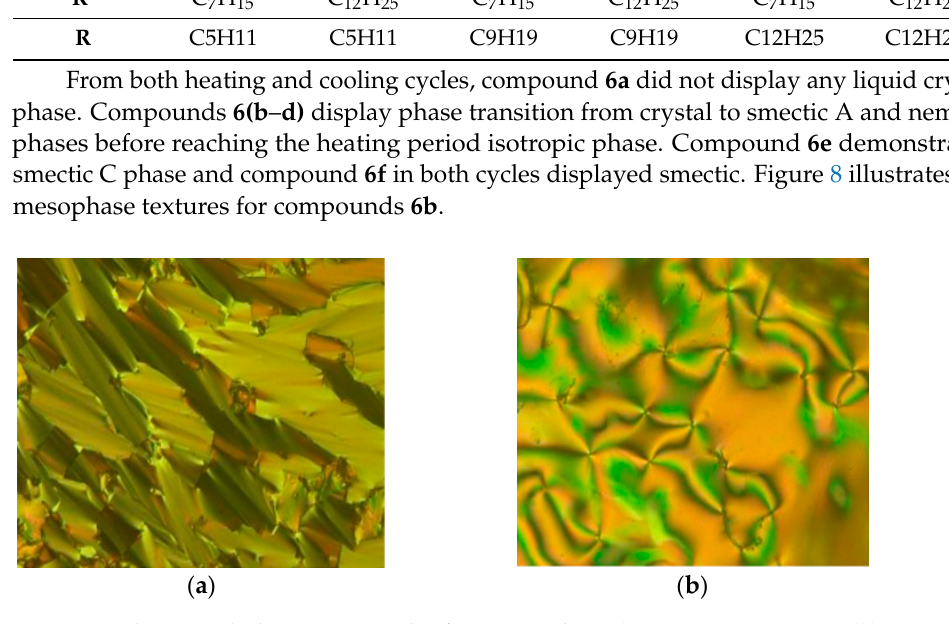
Figure 8. The optical photomicrograph of compound 6b ; ( a ) SmA at 126.21 °C; ( b ) nematic at 212.45 °C. Reprinted/adapted with permission from Ref. [37]; published by Malaysian Institute of Chemistry, 2019.